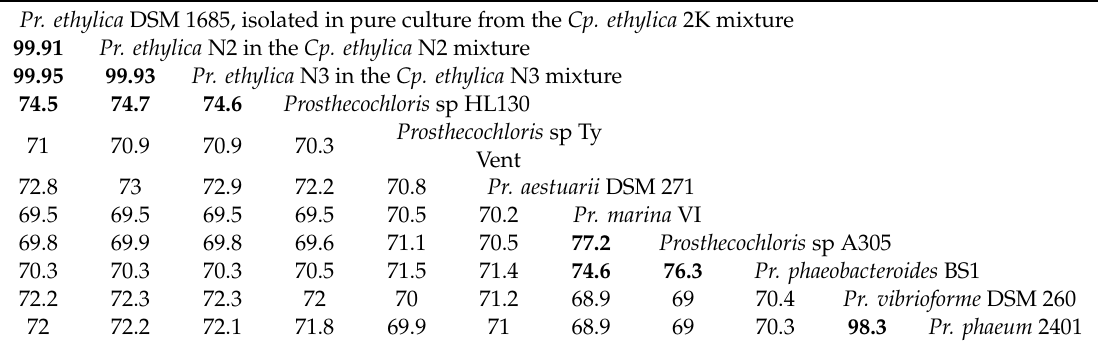
Table 2. Percentage Average Nucleotide Identity (ANIb) of Prosthecochloris green bacteria. Pr. ethylica DSM 1685, isolated in pure culture from the Cp. ethylica 2K mixture